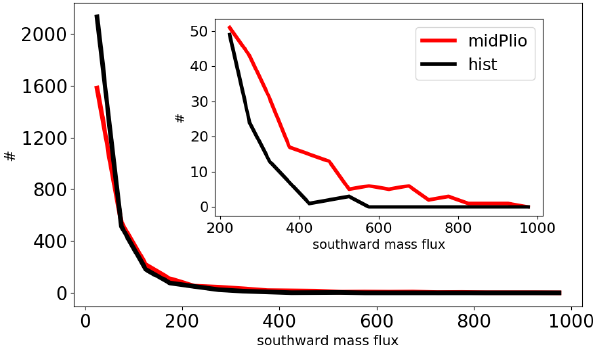
Figure 7. Probability density function ( y axis, in total number of dates) of 12-hourly southward upper-level (above 2000ma.g.l.) IWV mass fluxes ( x axis, in 10 6 kgs − 1 ) integrated between 80 and 70 ◦ W at 20 ◦ S (see yellow line in Fig. 5a) in WRF mP and WRF hist (outer model domain with 50km resolution) for South- ern Hemisphere winter. The inset zooms into the results above 200 × 10 6 kgs − 1